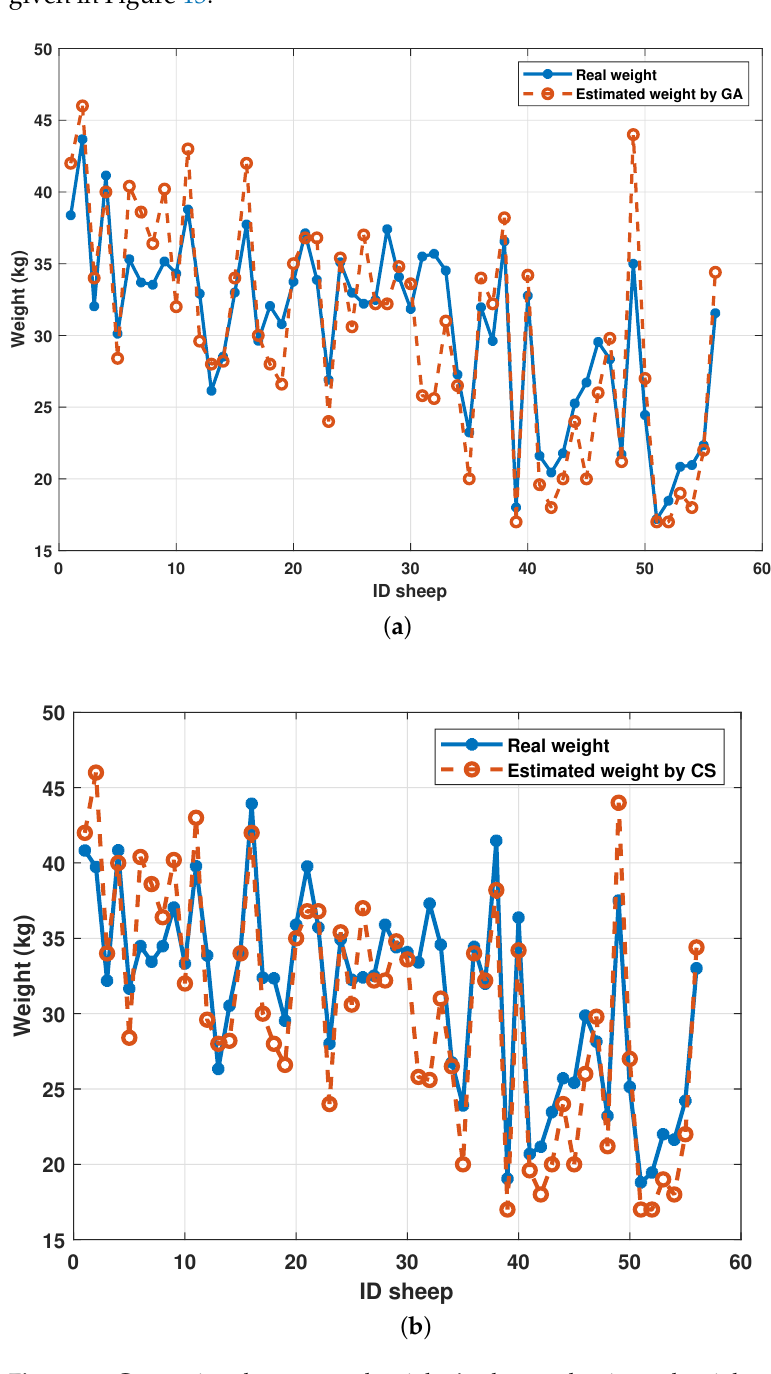
Figure 13. Comparison between real weights’ values and estimated weights. ( a ) Comparison using the genetic algorithm; ( b ) Comparison using the cuckoo search algorithm. The results are discussed in depth in Section